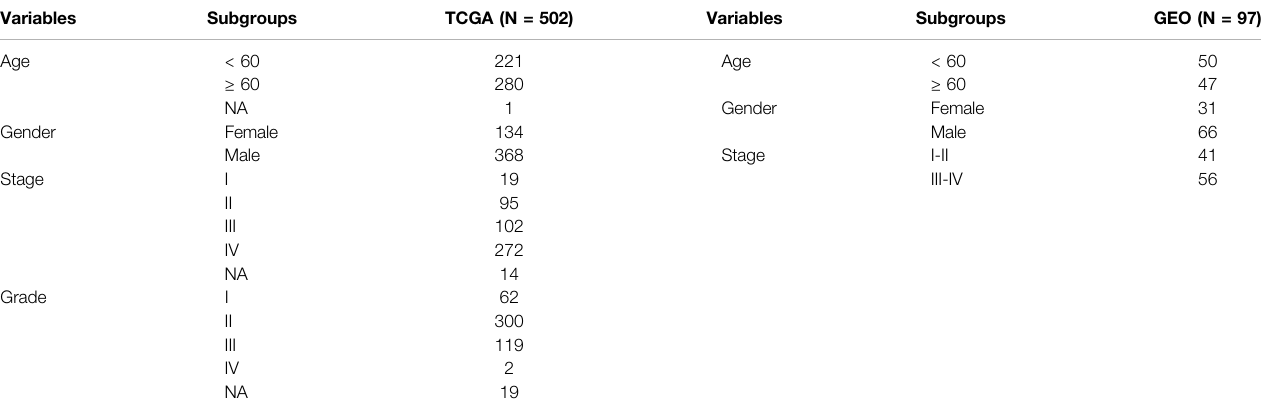
TABLE 1 | Clinical data of patients in the TCGA and the GEO validation